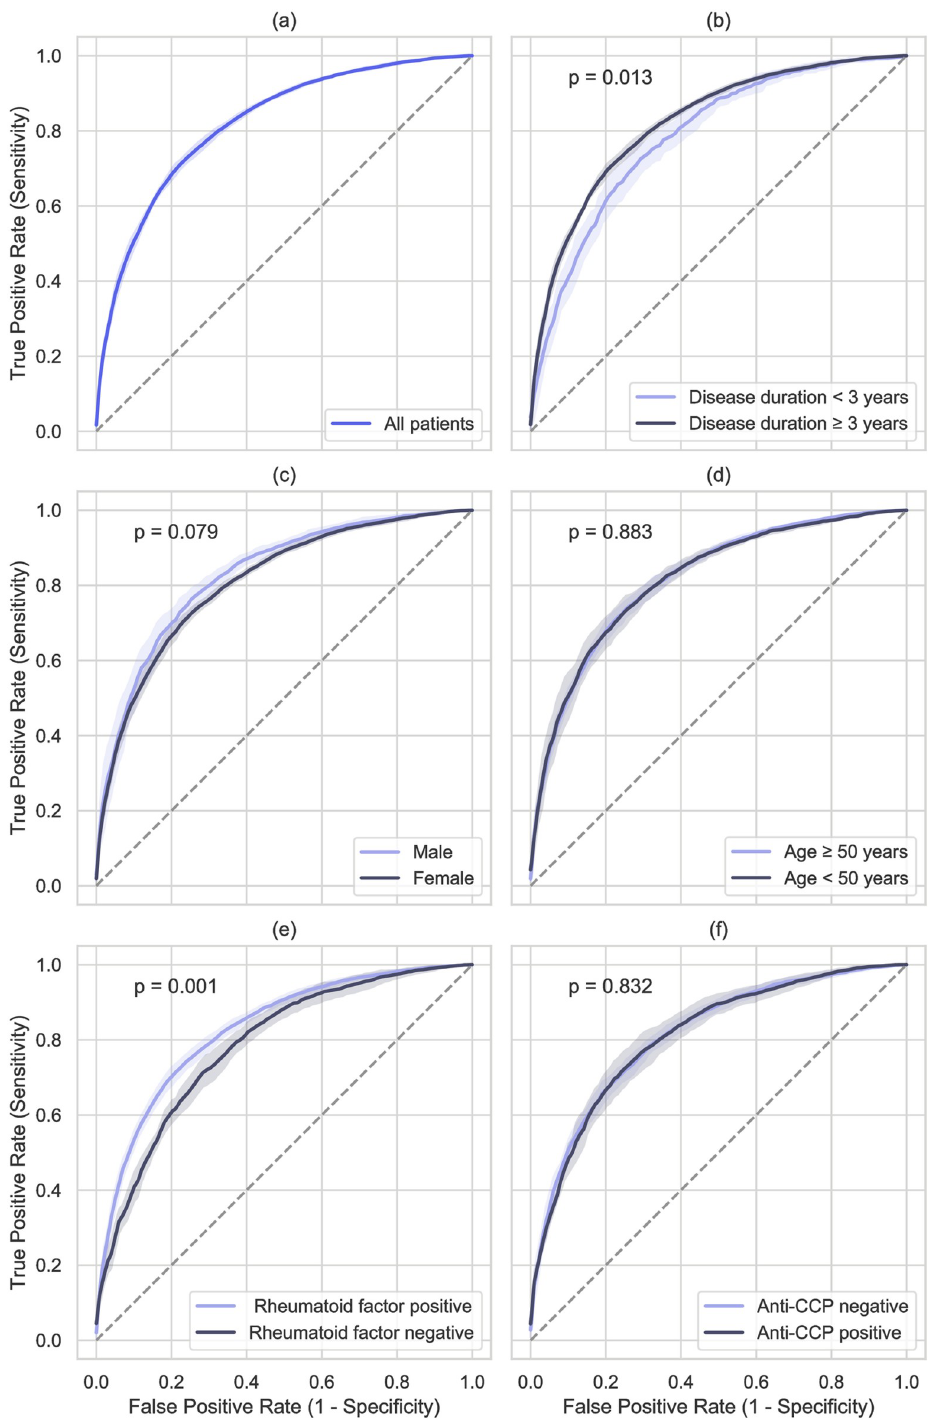
Fig 2. Classification performance of AdaptiveNet to predict active disease (DAS28-BSR > 2.6) in different patient subsets shown by Receiver Operating Characteristic Curves. Accuracy and corresponding AUCs are indicated